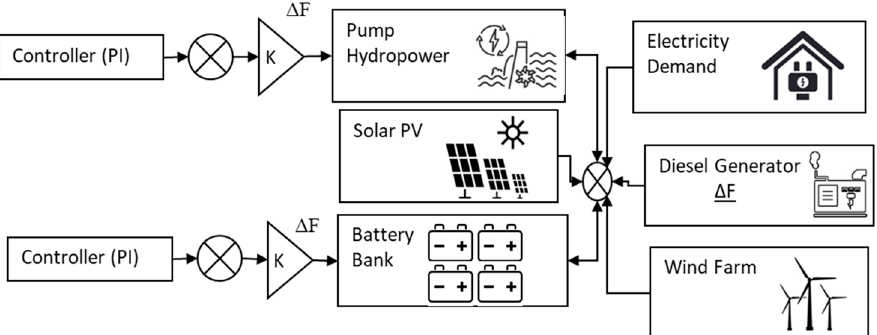
Figure 1. Schematic diagram of the isolated microgrid.